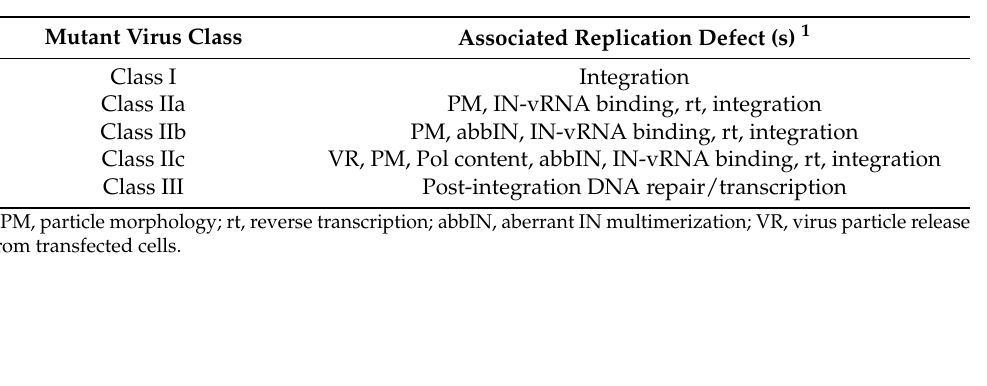
Table 1. Phenotypic classes of HIV-1 IN mutant